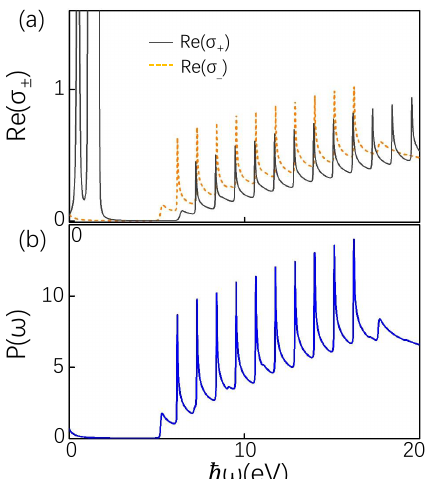
) for circularly polarized 2 π l B ) versus 2 π l B